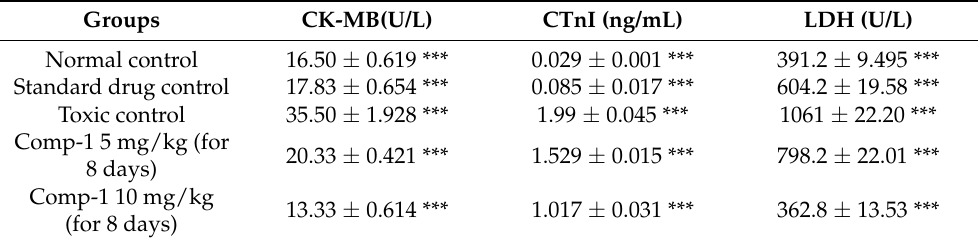
Table 1. Protective effects of Comp-1 on the activities of CK-MB, CTnl, and LDH in the serum of control and 5-FU-induced cardiotoxicity in rats.